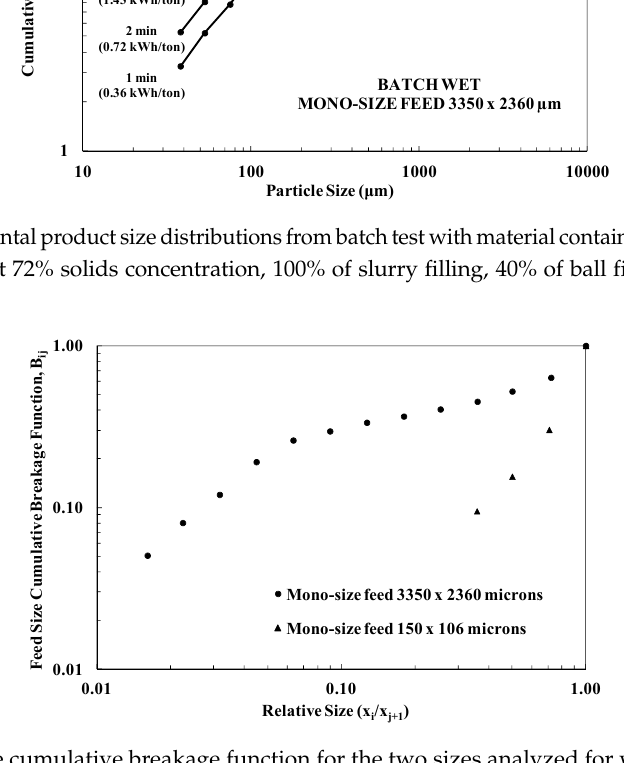
Figure 4. Feed size cumulative breakage function for the two sizes analyzed for wet grinding in the 25.4 cm diameter mill.